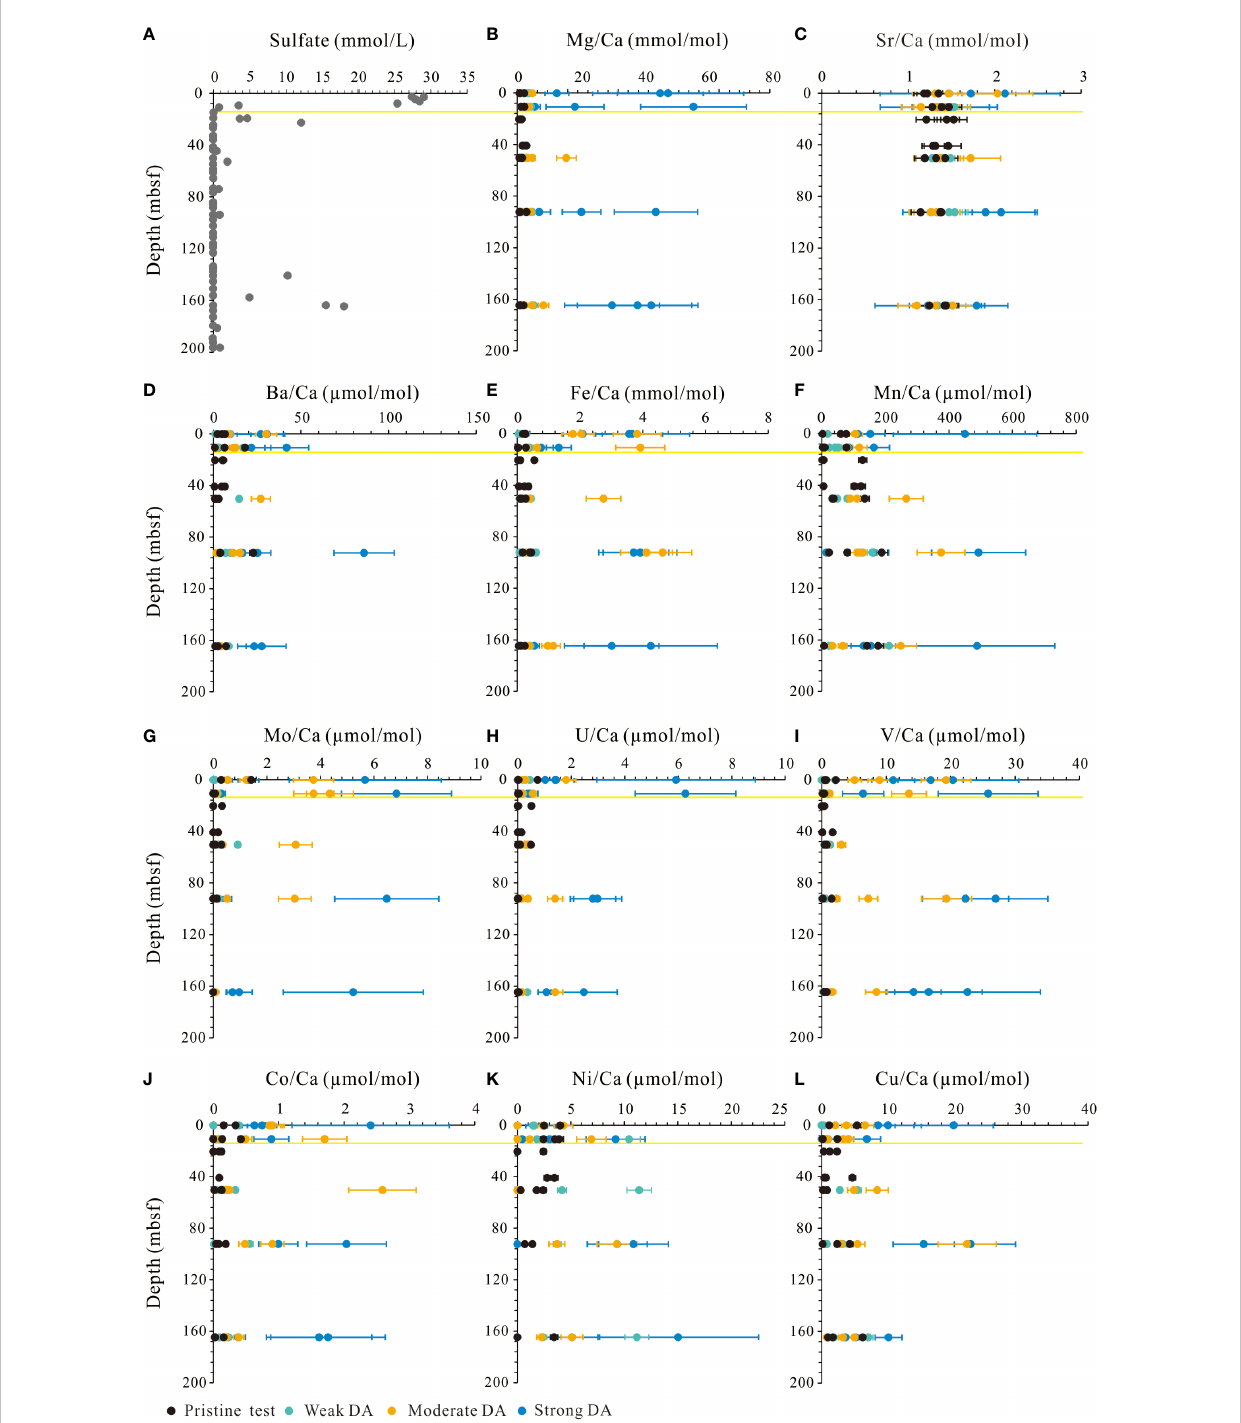
FIGURE 9 Sulfate (A) (Kuang et al., 2018) and elemental-ratio (B – L) pro fi les for Site GMGS2-16. The samples are coded according to diagenetic alteration stage: pristine (black), weakly altered (green), moderately altered (orange), and strongly altered (blue). Error bars represent one standard deviation. The yellow lines show the depth of the current sulfate-methane interface (SMI; i.e., where porewater sulfate declines to